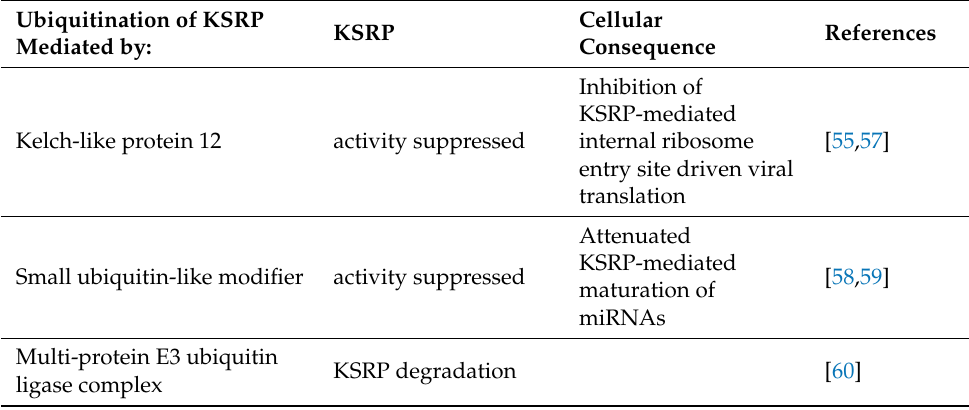
Table 4. Modification of KSRP by